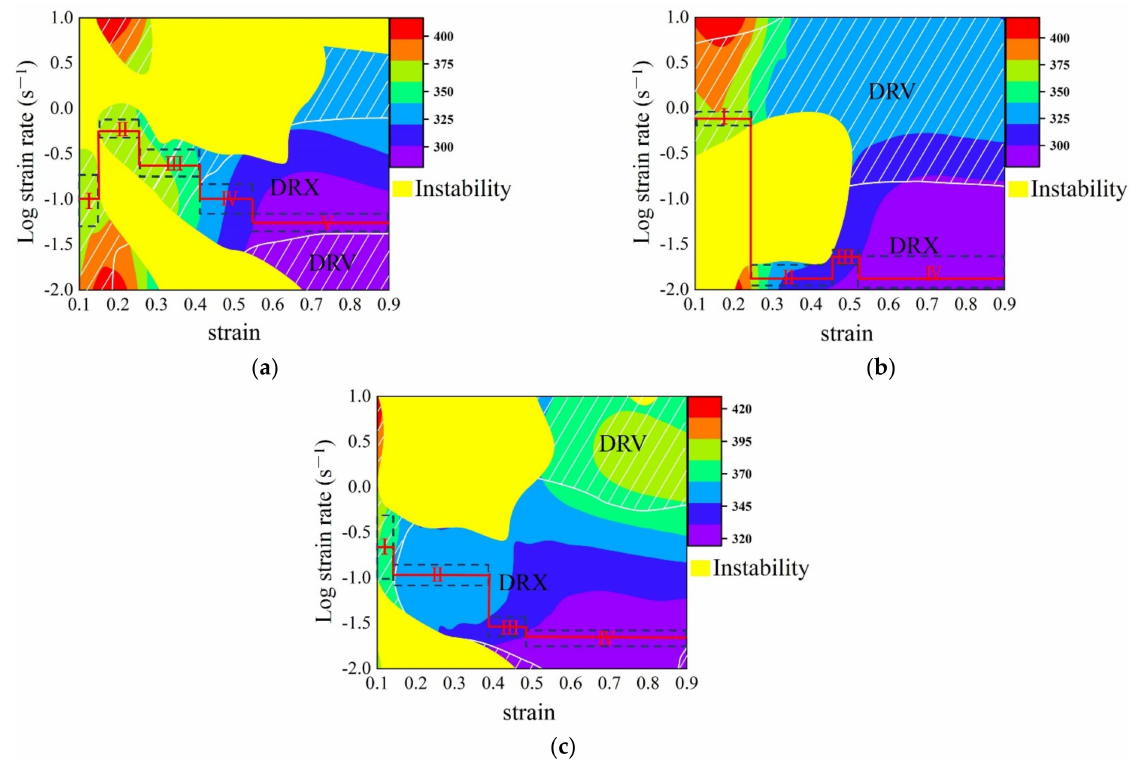
Figure 19. Enhanced deformation mechanism map of SAE 5137H steel at different temperatures of